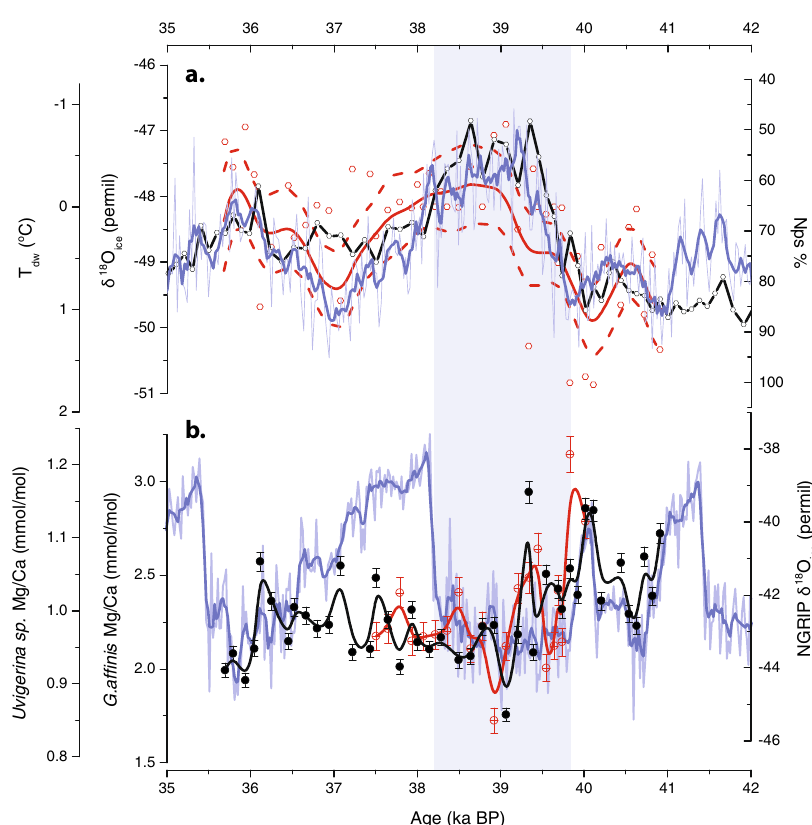
Fig. 2 Down-core G. af fi nis and Uvigerina sp. Mg/Ca results, compared with the Greenland and Antarctic ice-core event stratigraphies. a Polar planktonic foraminifer, N. pachyderma (left coiling) abundance (black solid line and open circles, Nps %), compared with the EDML Antarctic ice-core temperature proxy, δ 18 O ice (blue line) 4 , and with deep-water temperature variability estimated from combined Mg/Ca measurements from two benthic foraminifer species (open red circles, with cubic spline and 95% con fi dence intervals, based on 0.6 °C 1 sigma uncertainty, are indicated by the solid and dashed red lines respectively; note inverted y axis). b benthic Mg/Ca measurements ( G. af fi nis , solid black circles and spline; Uvigerina sp ., crossed red circles and spline; error bars represent 2% analytical reproducibility), compared with the Greenland ice-core temperature proxy δ 18 O ice (light blue line, with dark blue running mean) 51 . Vertical shaded bar indicates the approximate timing of Heinrich Stadial 4